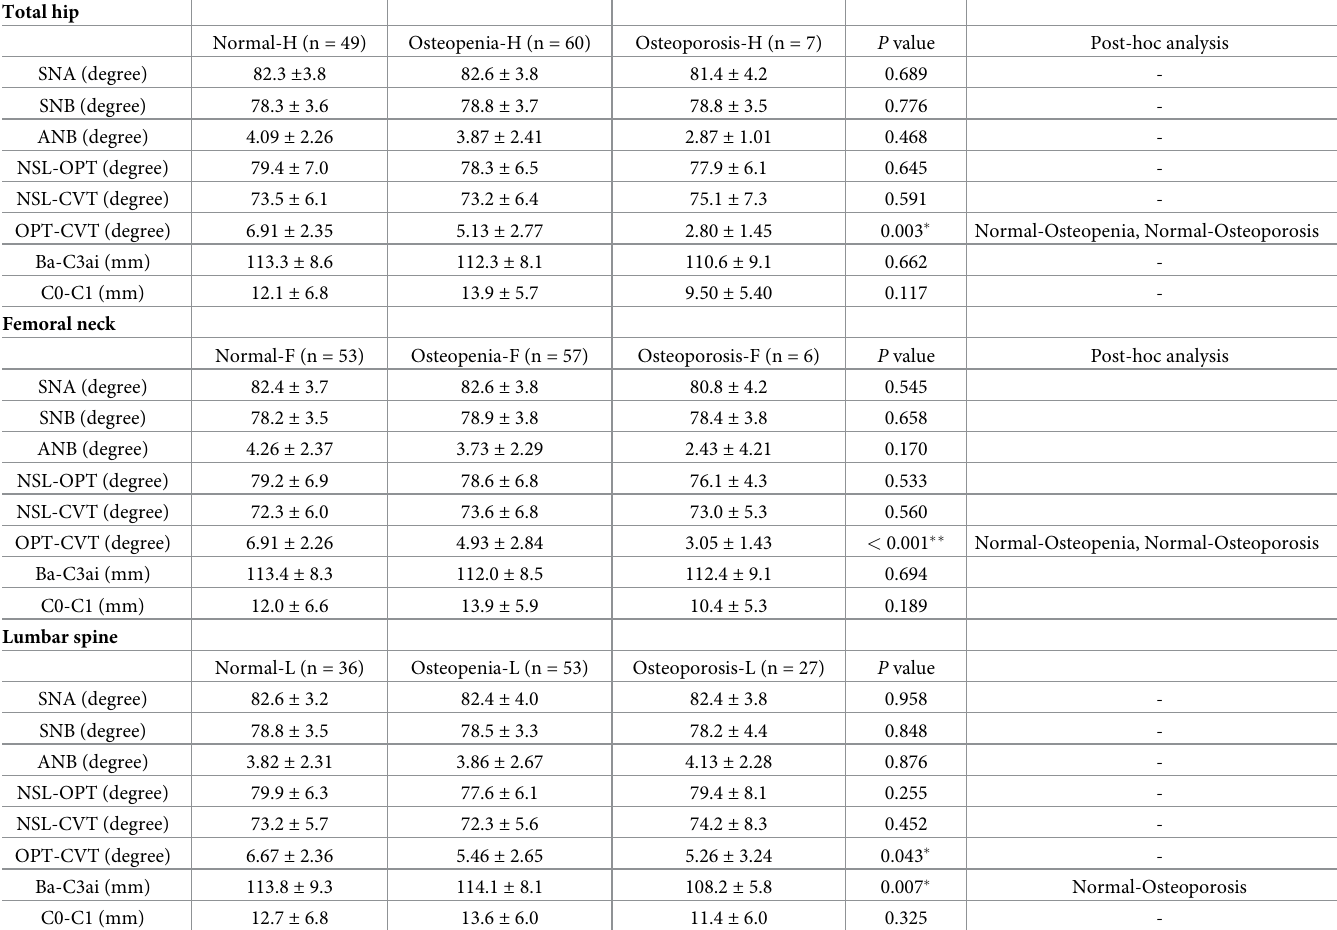
Table 3. Variables related with head and neck postures and facial